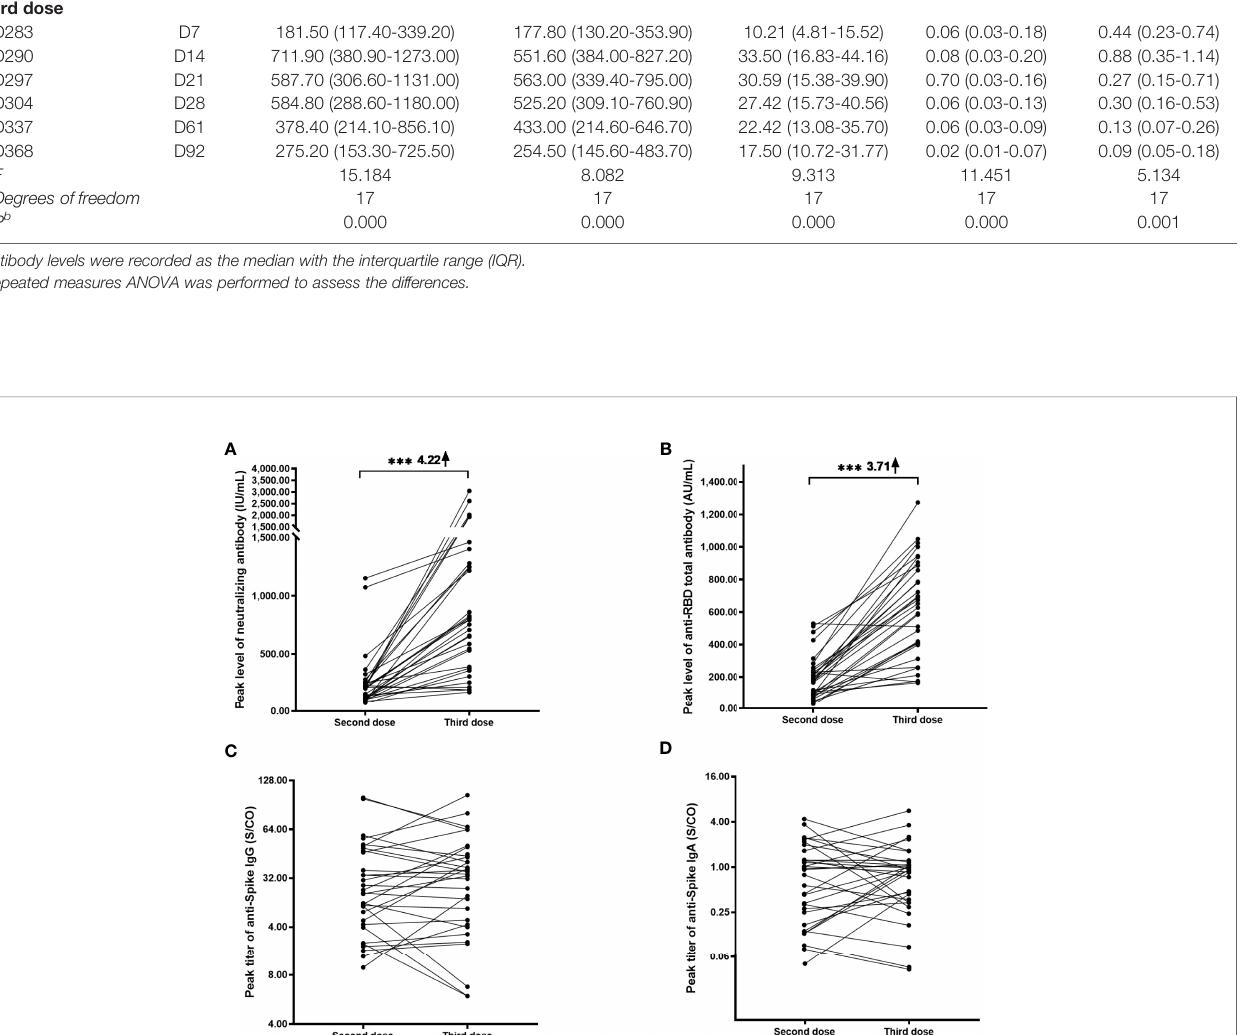
Day since Neutralizing antibody (IU/ dose mL)